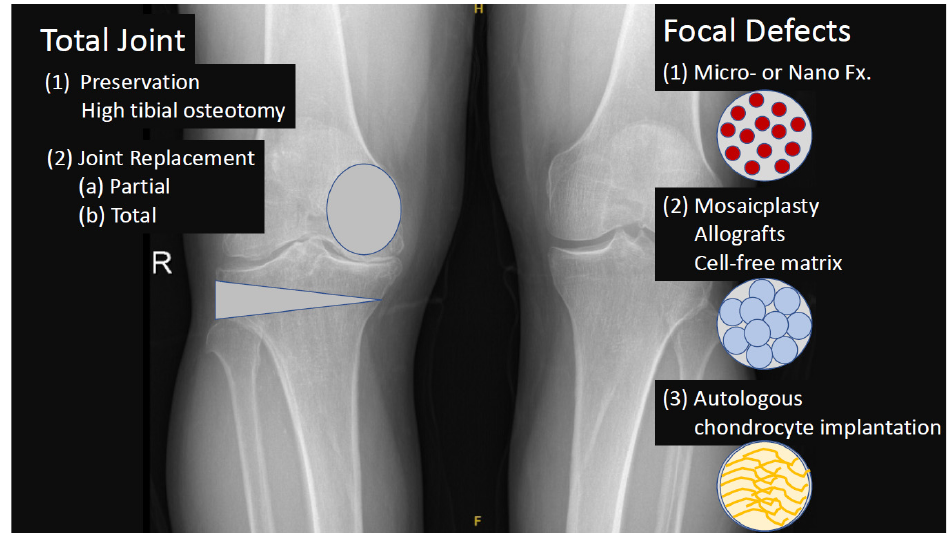
Figure 3. Surgical methods for treating articular cartilage defects and